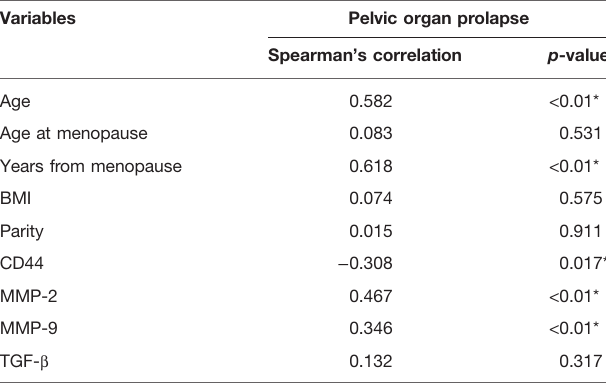
TABLE 2 | Correlations between pelvic organ prolapse and risk